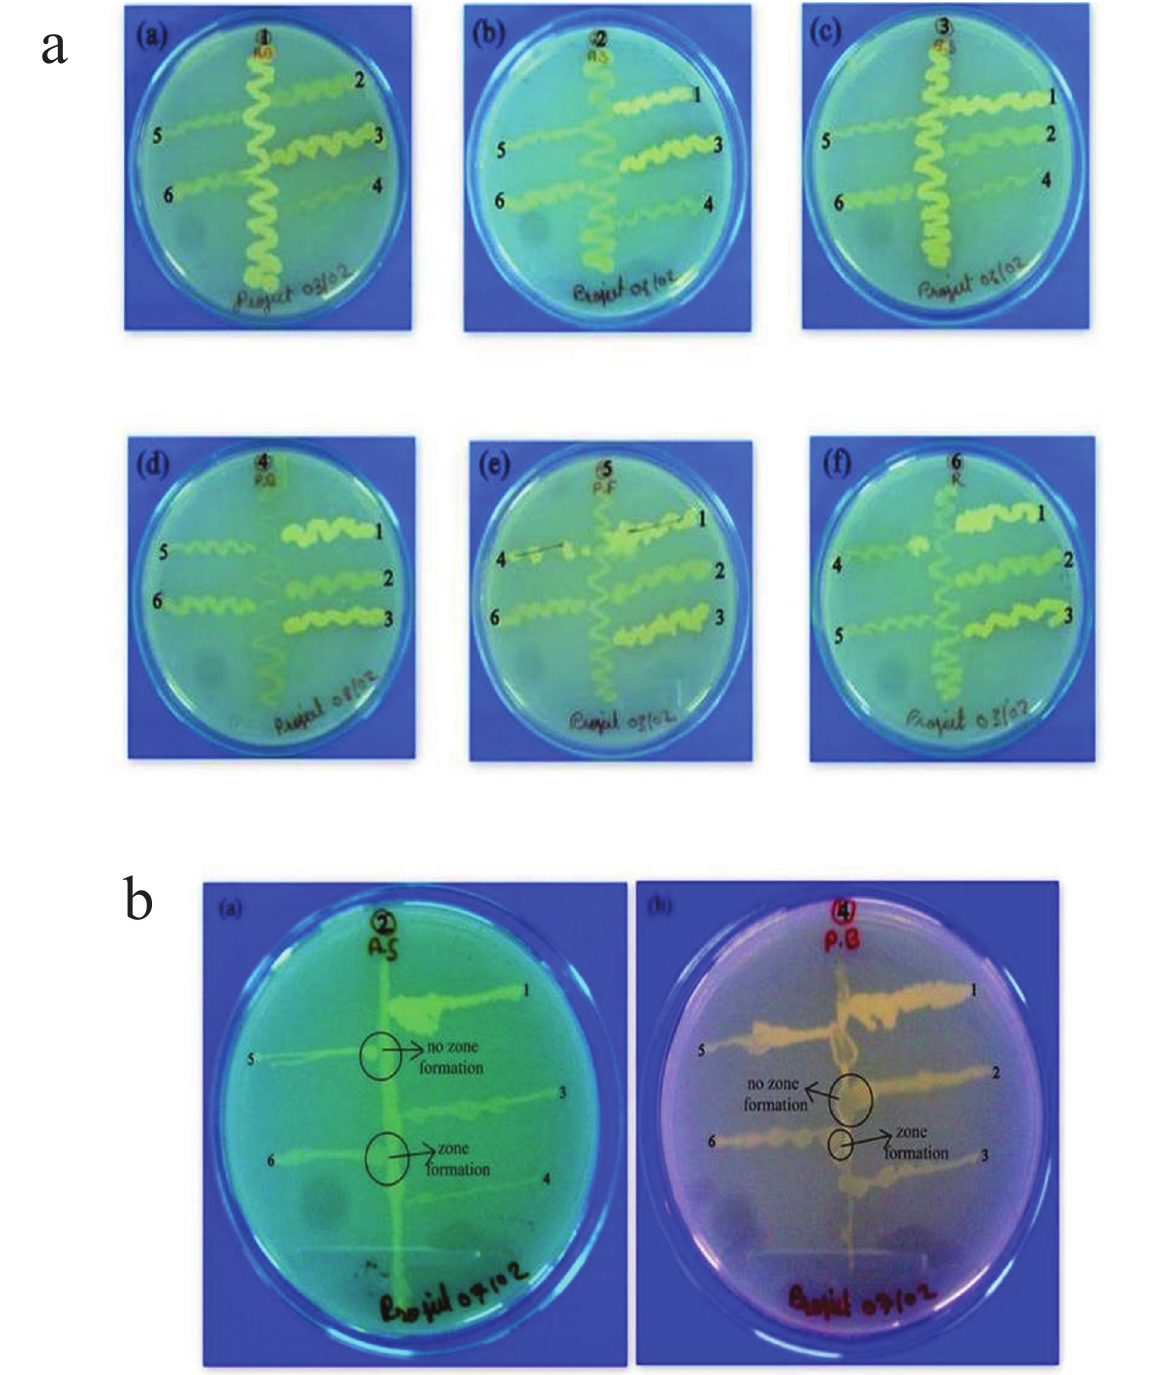
Figure 1 - Cultural compatibility test of rhizosphere inhabiting beneficial bacteria. a . Compatibility among six different